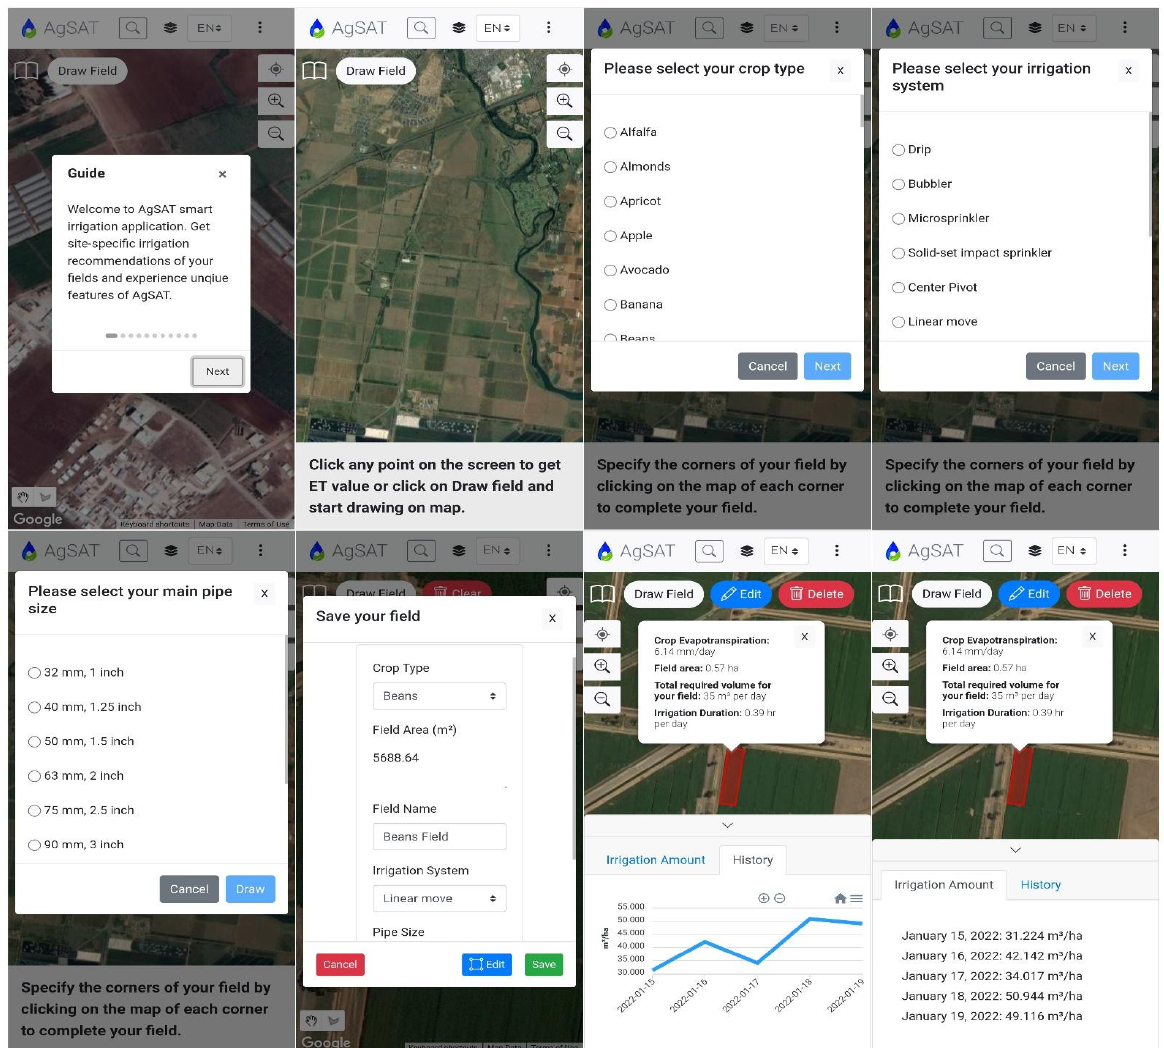
Figure 2. The mobile user interface of the AgSAT Android smartphone application.